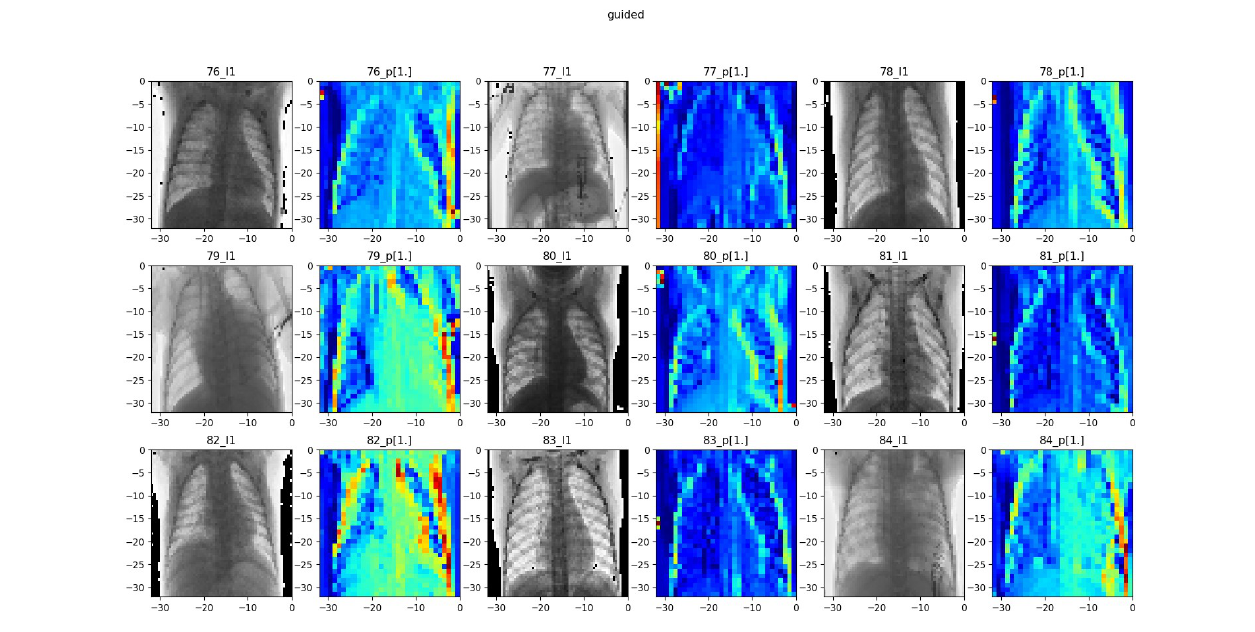
Figure 4. Visualizations of X-ray images and the generated abnormalities regions images on normal person respectively.